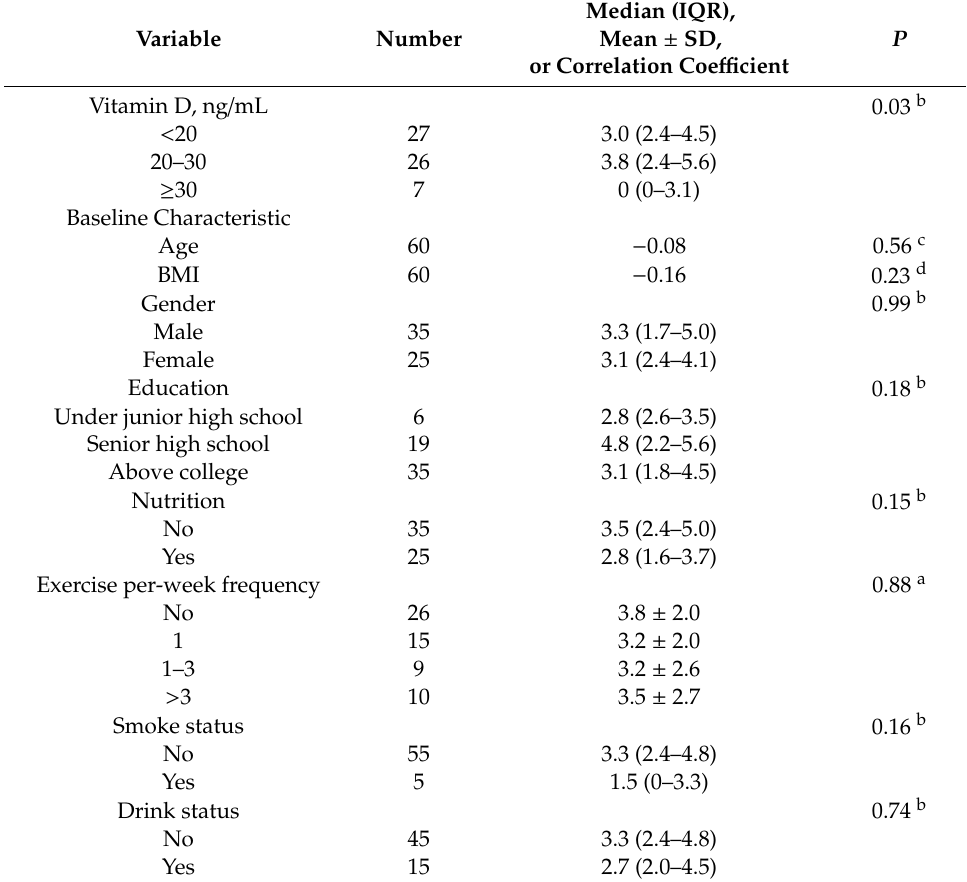
Table 4. Factors associated with HBV DNA serum concentration (log10 IU /